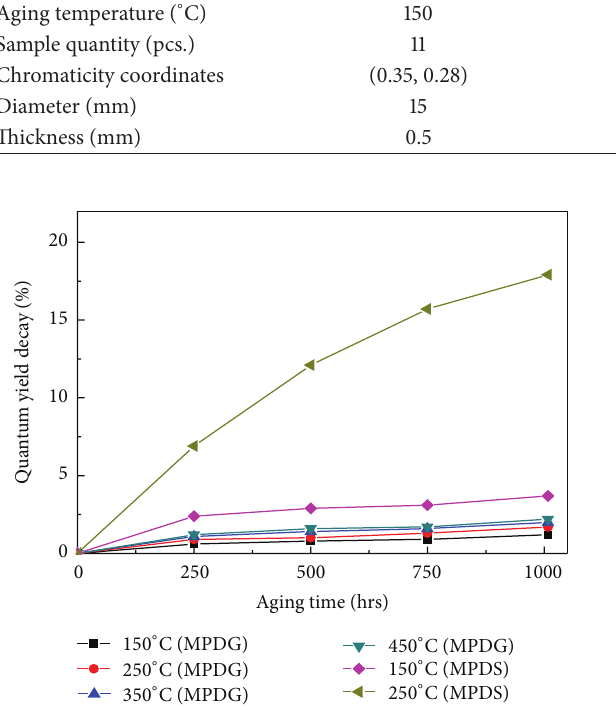
Figure 3: The CRI remanence versus aging time for PC-WLEDs of MPDG and MPDS samples at different